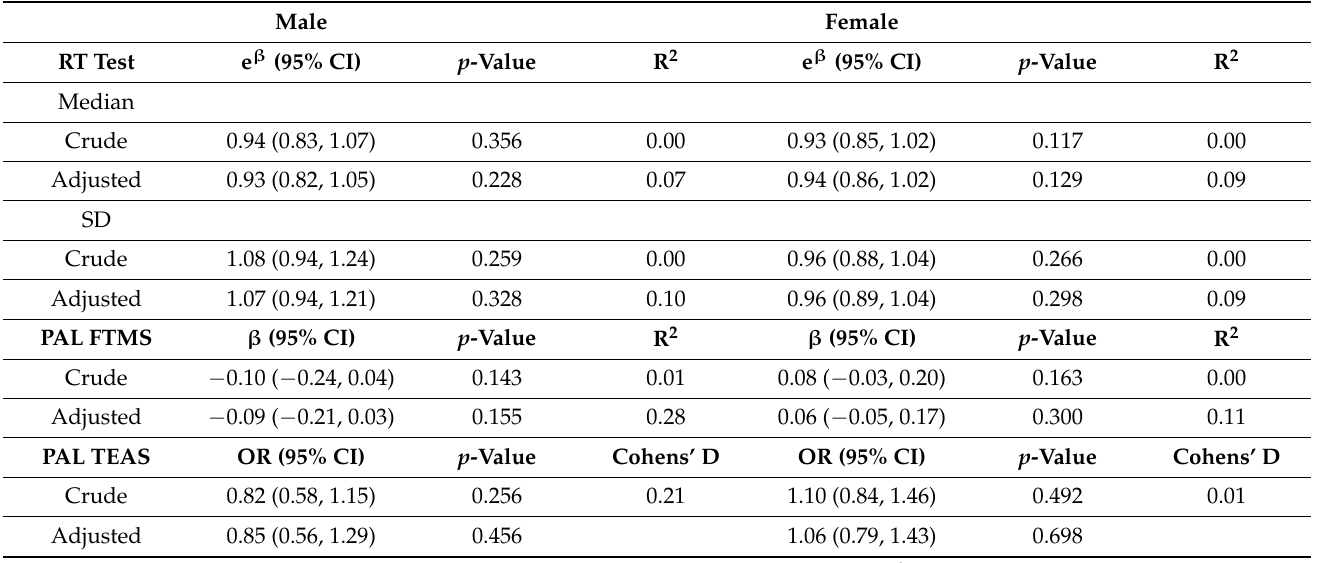
Table 5. Association of hazardous drinking PGS with RT test and PAL test in male and female schizoaffective disorder patients. Male